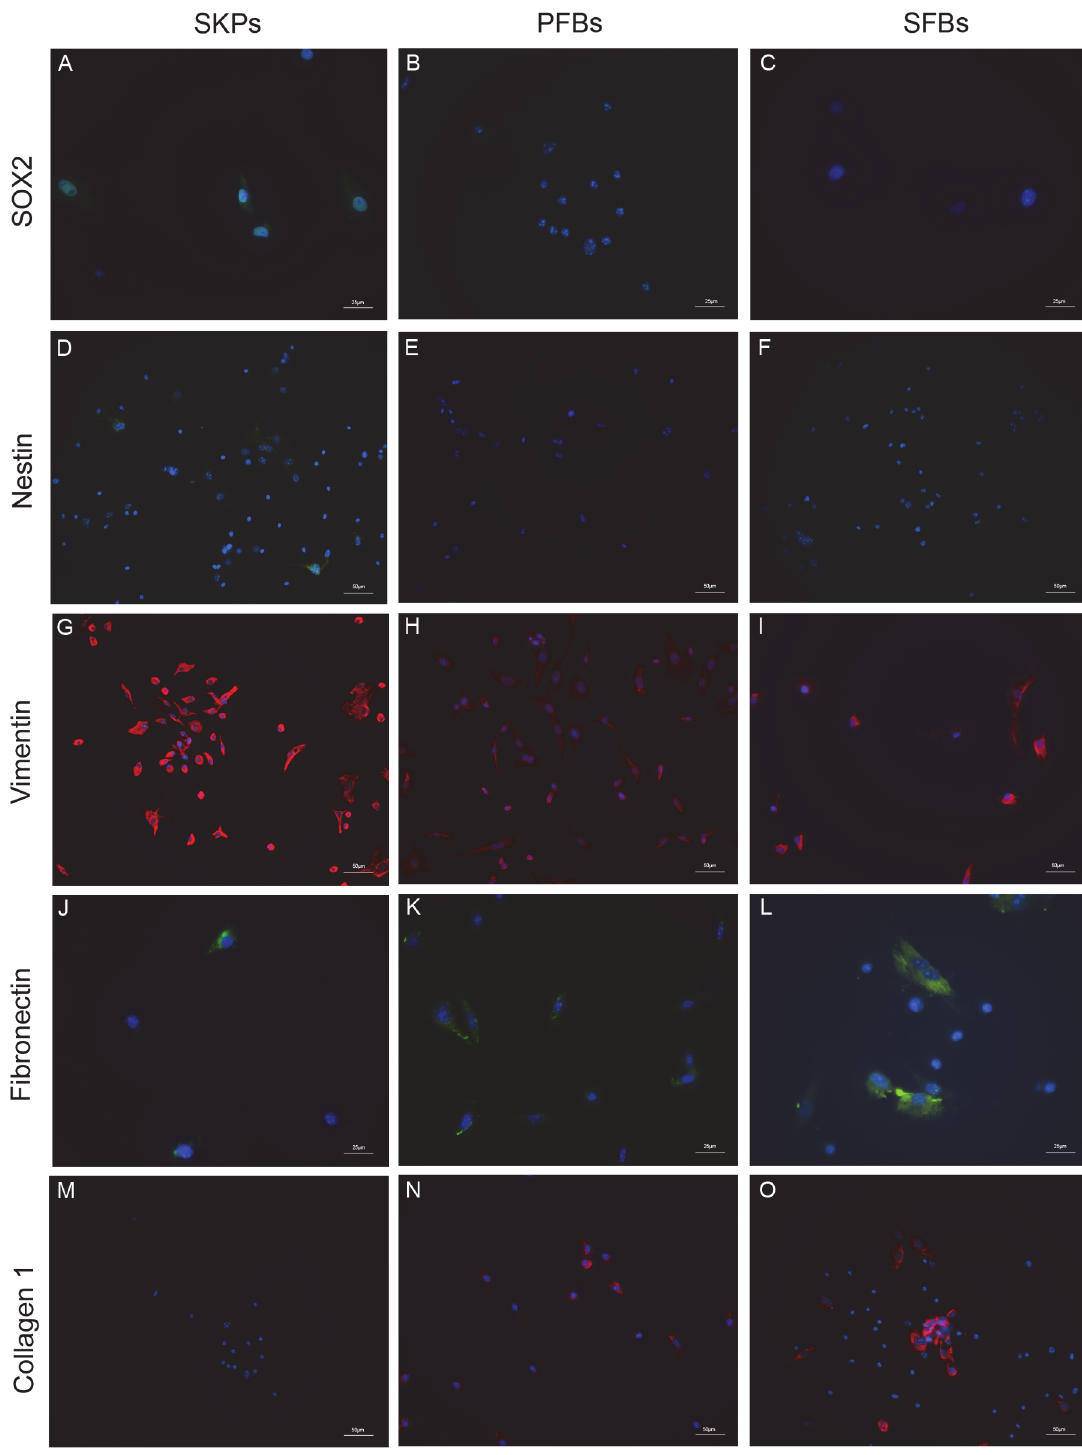
Fig 2. Characterization of SKPs and SFBs by immunocytochemistry. SKP spheres expressed SOX2(A), nestin(D), vimentin(G) and fibronectin(J), did not express collagen 1(M); SFBs expressed vimentin(I), fibronectin(L) and collagen 1(O), did not express SOX2(C) or nestin(F). The same results were observed with PFBs(B, E, H, K and N). Scale bars, 25 μ m(A-C, J-L); 50 μ m(D-I, M-O).